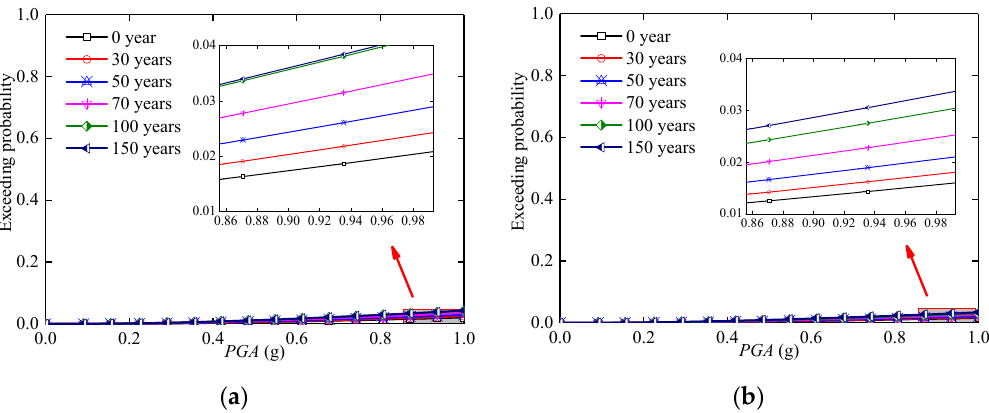
Figure 9. Time-variant fragility curve of bearing in the state of complete damage: ( a ) 1 # Bearing; ( b ) 3 # Bearing.